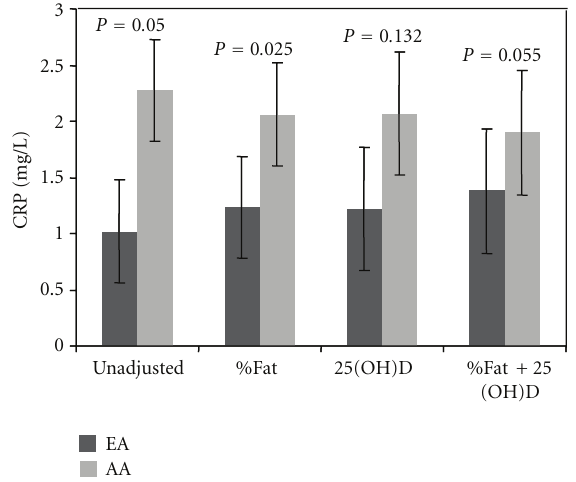
Figure 2: Ethnic di ff erences in hs-CRP (a) unadjusted, (b) adjusted for percent body fat, (c) adjusted for 25(OH)D, and (d) further adjusted for percent body fat and 25(OH)D. After adjusting for serum concentration of 25(OH)D, there was a 32% reduction in hs-CRP di ff erence between AA and